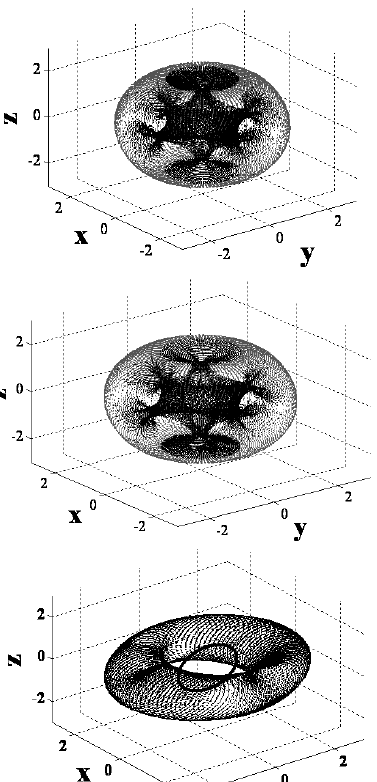
Figure 3 . Six possible combinations of mixed skew angles laying one or two momentum cutting planes from 0° to 90°. Corresponding singular hypersurfaces are depicted in respective order in Figure 4.